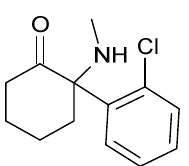
Figure 1. Structure of